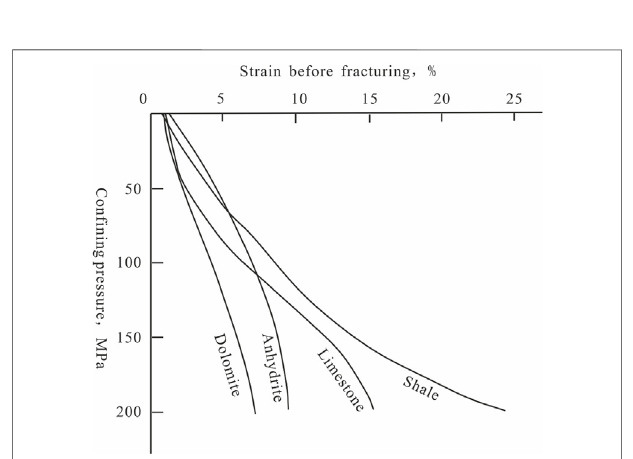
FIGURE 8 | Strain curves of rocks before forming fractures under different con fi ning pressures (modi fi ed after Ferrill et al., 2017).